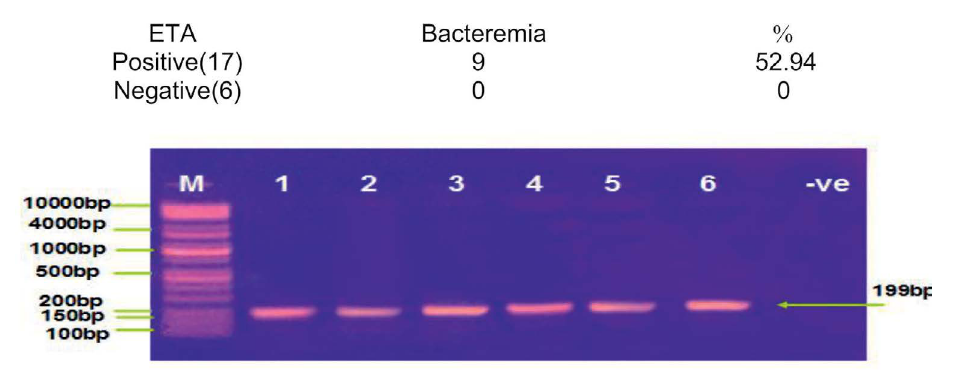
Fig. 1. Electrophoresis agar gel of PCR of P. aeruginosa ETA gene . Where, Lane (M) marker of DNA (100bp), Lane ((1-3)) samples that were positive in burn wound infections patients Lane (4-6) positive samples in mastitis milk samples at 199bp and Lane negative ETA gene in P. aeruginosa